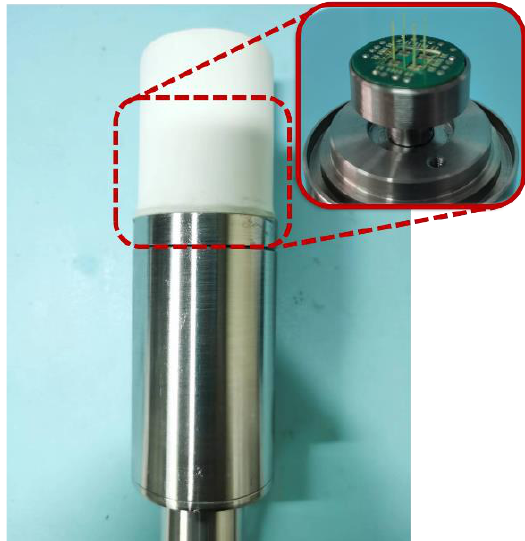
Figure 11. Image of the completed FUVH hydrophone.